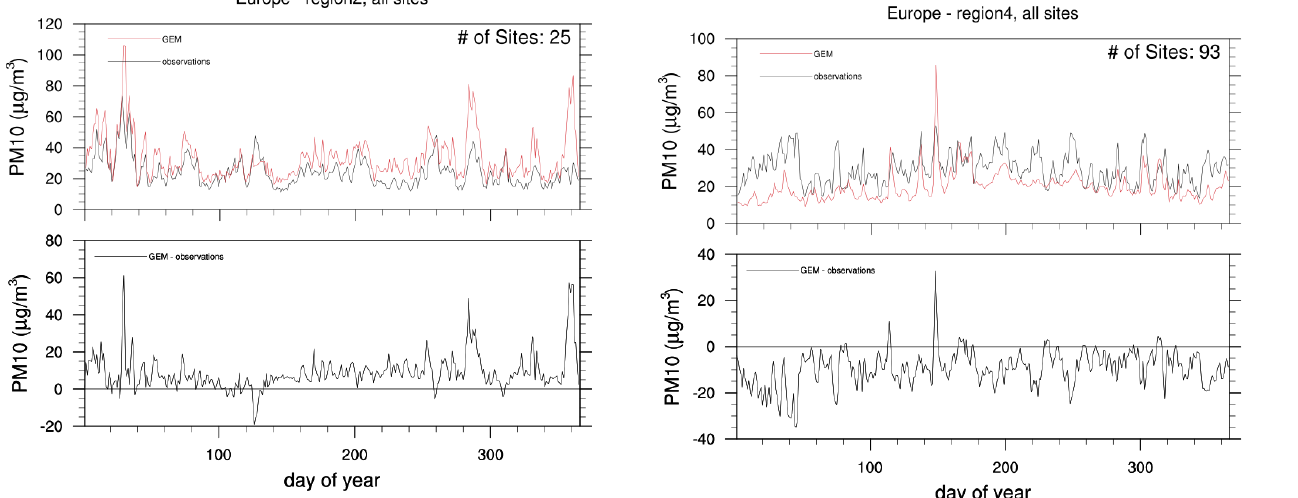
Figure 22. Time series of observed and modelled PM 10 24h con- centration averaged for all stations in southern Europe and